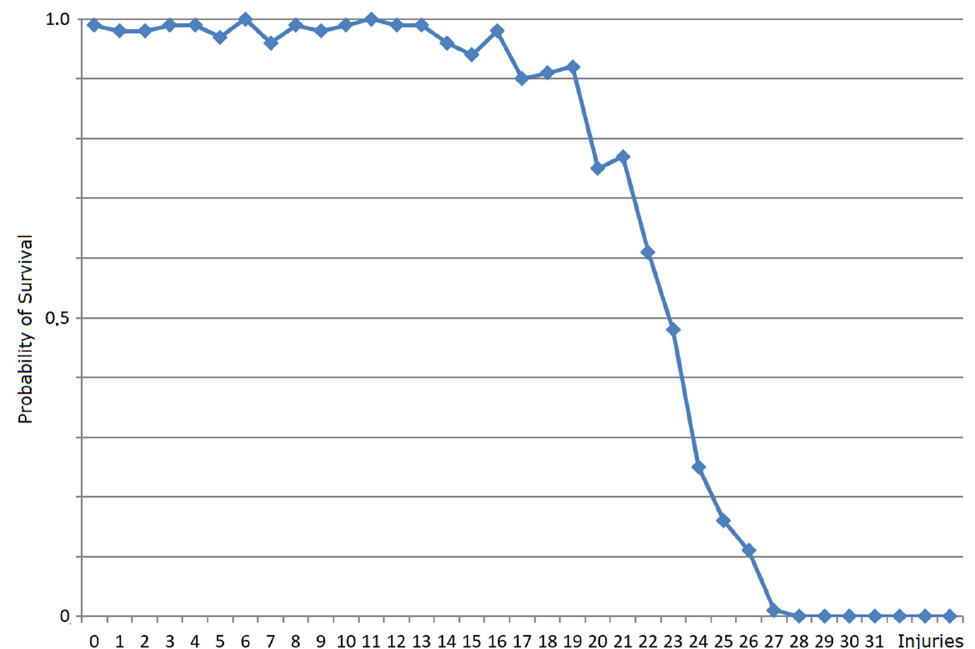
Figure 6. The x -axis shows the number of simultaneous random injuries (of any kind) to any of 34 components in an adult individual. The y -axis shows the probability of survival to adulthood and reproduction, under abundant nutrient supply, averaged over 100 runs of the experiment. This probability drops under 50% with over 23 injuries.